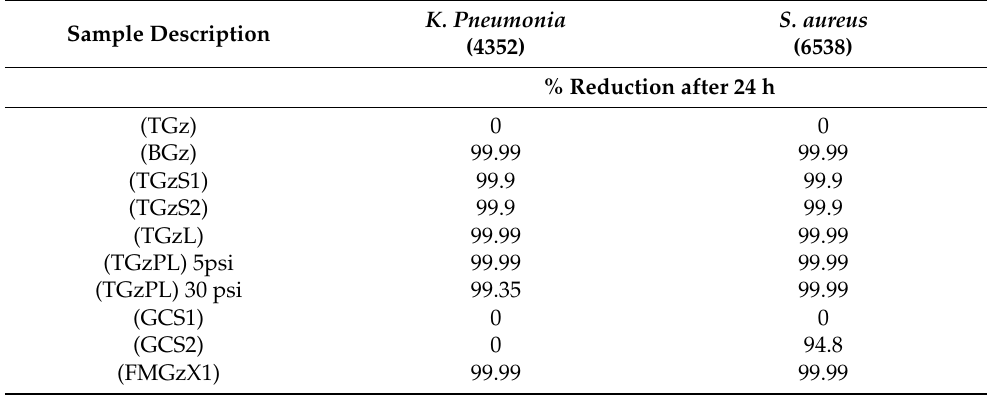
Table 2. Antimicrobial results of prototypes, pilot, and lab-treated samples using the AATCC 100 test method a against two standard